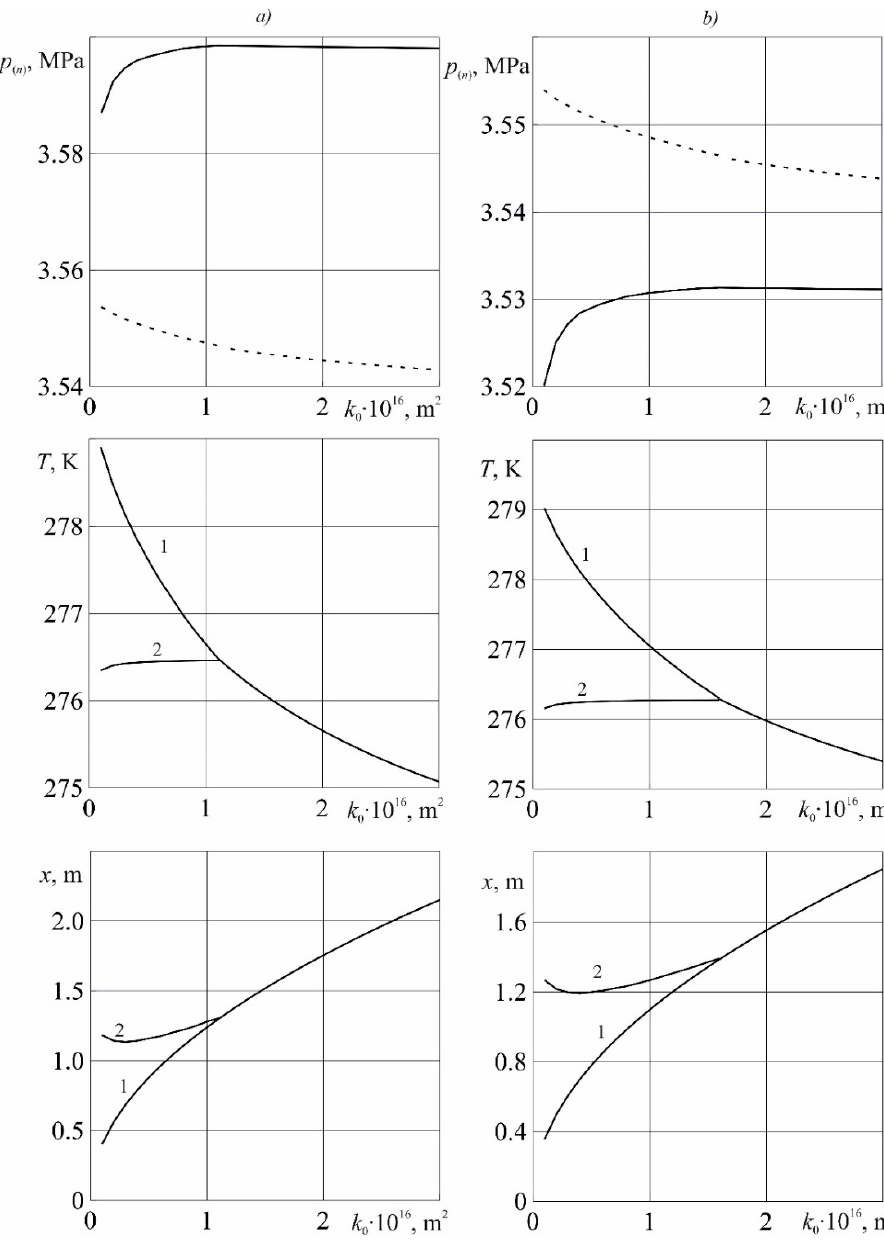
Figure 6. Dependencies of pressure values, temperatures and coordinates of phase transition boundaries from reservoir permeability. p e = 3.75 MPa ( a ) and 3.65 MPa ( b ).